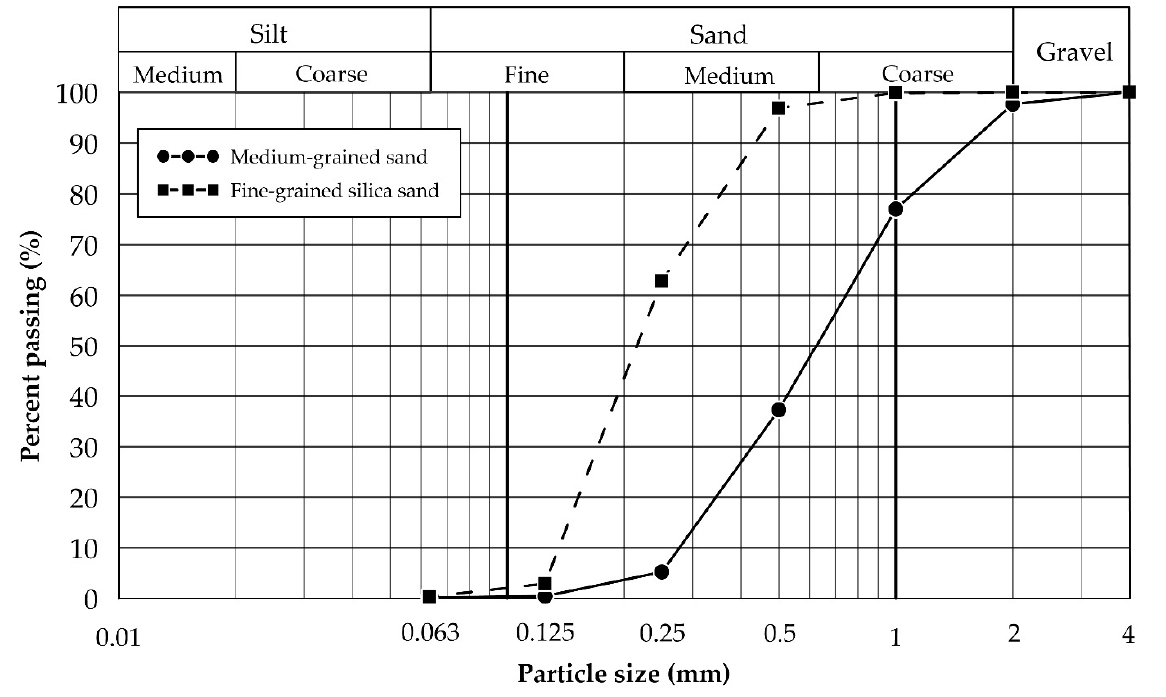
Figure 1. Particle-size distribution of medium-grained sand and fine-grained silica sand, determined according to DIN EN ISO 17892-4 [29].